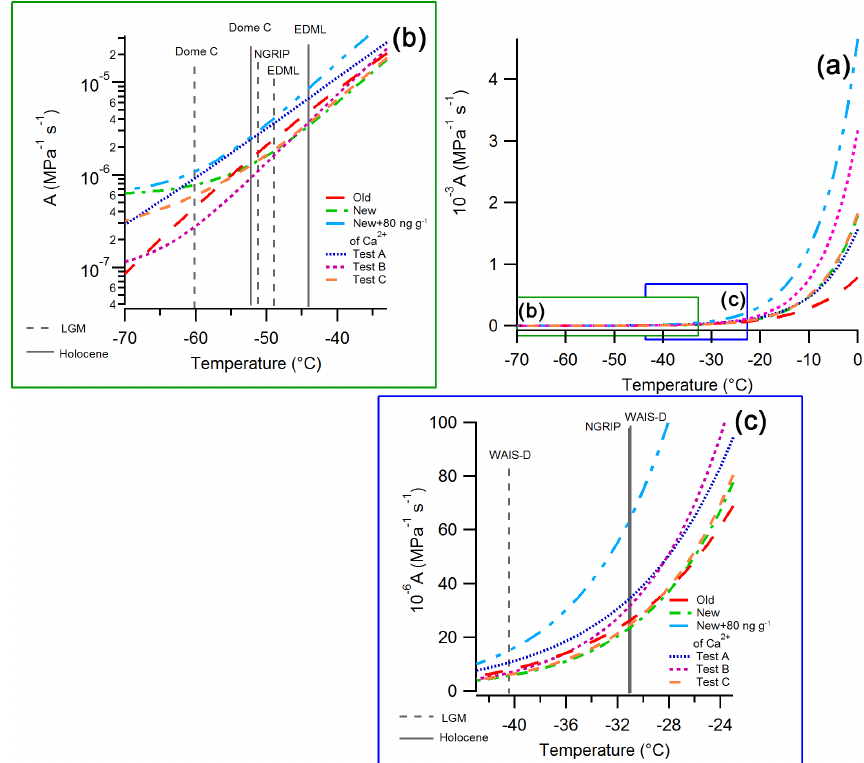
Figure 8. Dependence of the creep parameter (Eq. 7) as a function of temperature for six different parameterizations. “Old” corresponds to the Goujon et al. (2003) version of the model; “New” corresponds to the improved LGGE model with parameterization described in Table 1; “New + 80ngg − 1 of Ca 2 + ” corresponds to the parameterization of Table 1 with the addition of the impurity effect following Eq. (8) and a [Ca 2 + ] value of 80ngg − 1 ; tests A, B, and C are sensitivity tests run with the values presented in Table 3. Panel (a) shows the creep parameter evolution for the whole temperature range, (b) is a focus at very low temperature, and (c) is a focus at intermediate temperature. The grey vertical lines indicate the temperature for the early Holocene (EH, solid line) and LGM (dotted line) at the four study sites presented in Figs. 6 and